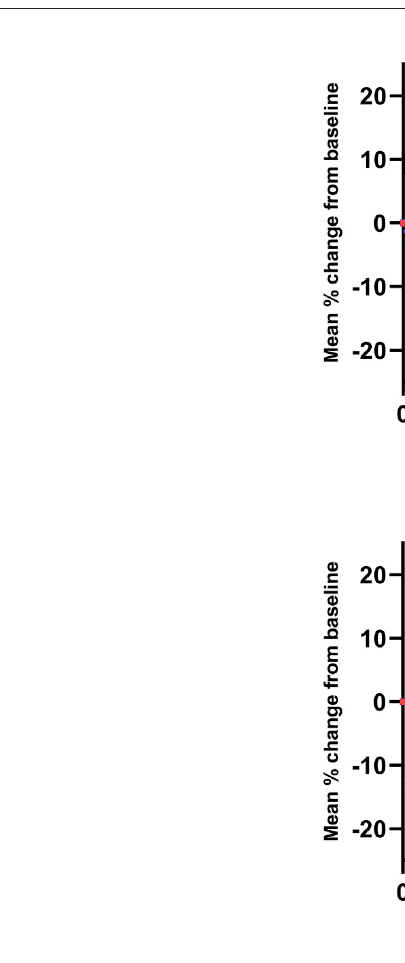
Frontiers in Physiology |